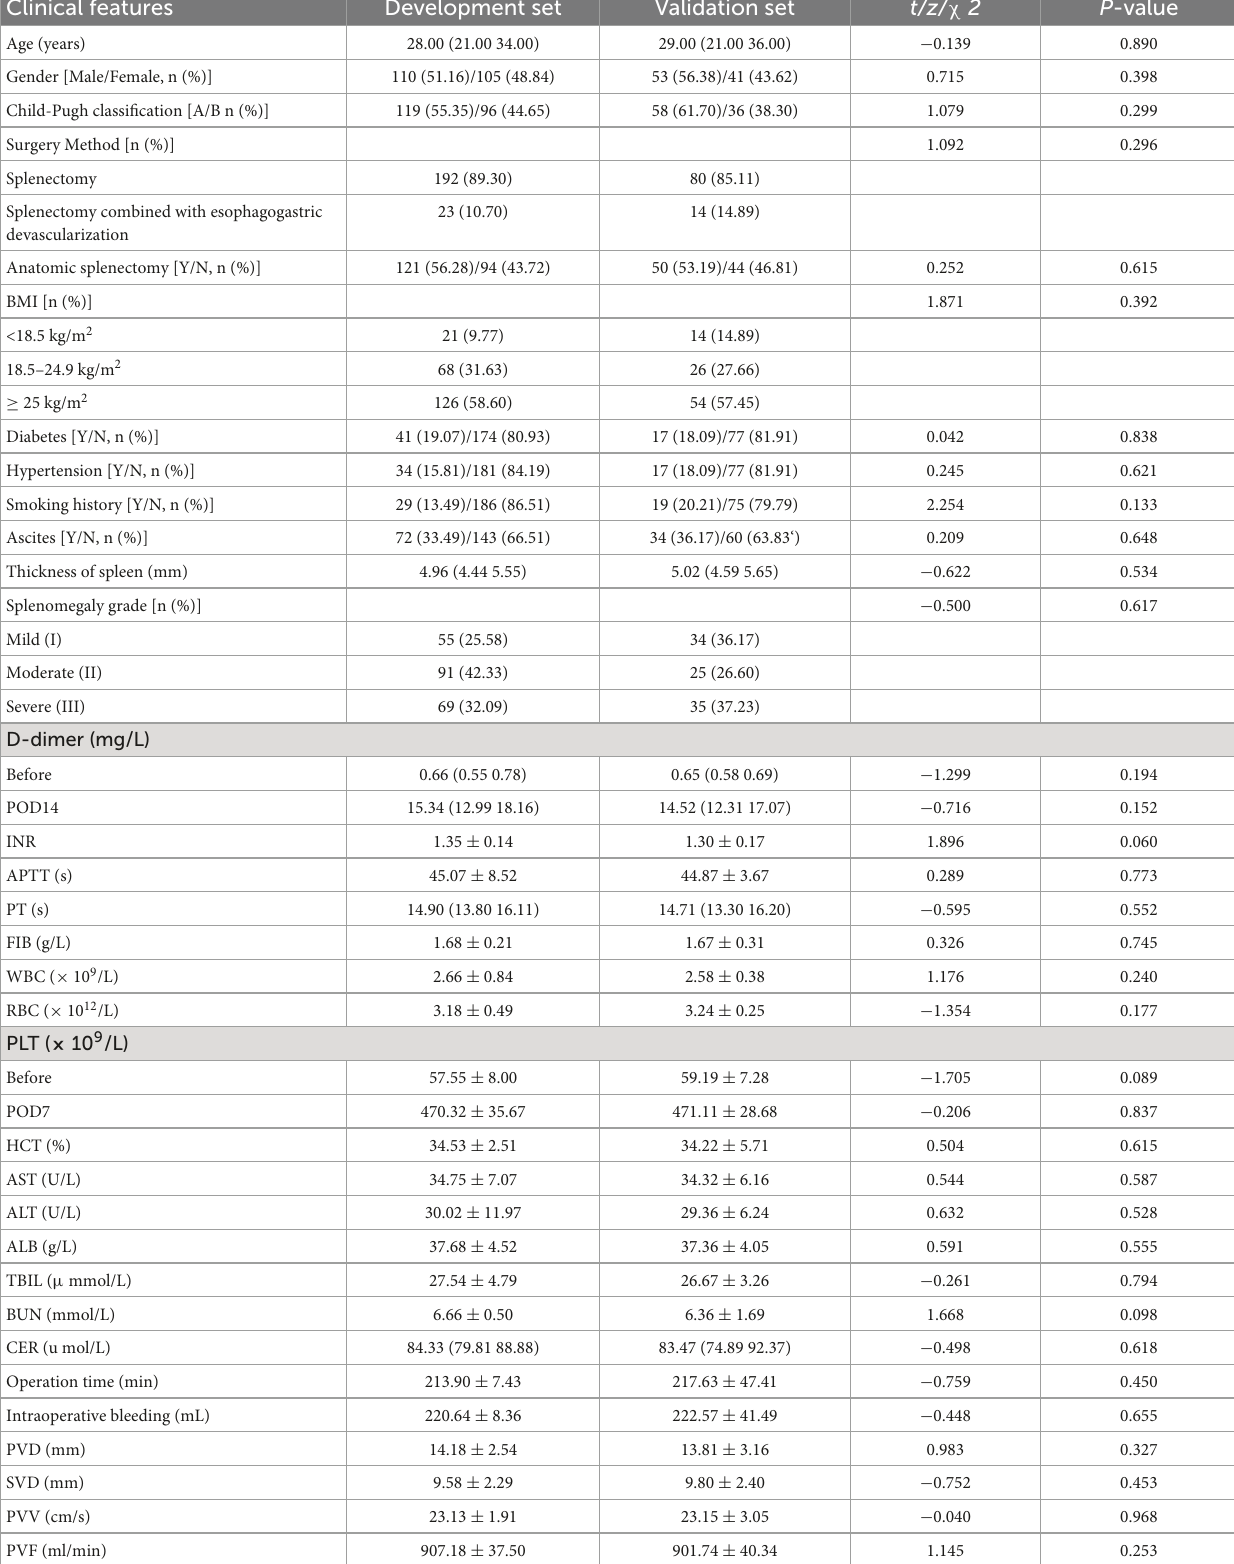
TABLE 1 Feature comparison of development set and validation set. Clinical